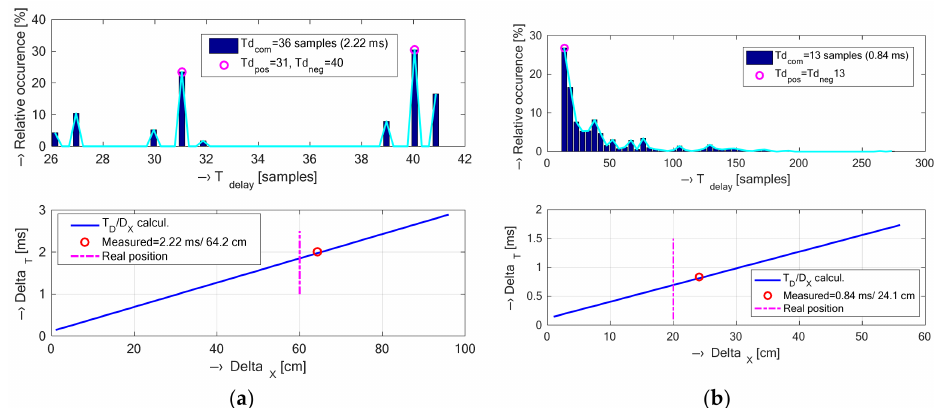
Figure 9. Histograms of evaluated time delays [samples] between electrical excitation and acoustic noise signals recorded in the MRI device (upper set), comparison of calculated and estimated mean values of time delays [ms] together with theoretical and real microphone distances (lower set); ( a ) for MRI Opera microphone Mic. 1 at a distance 60 cm and a direction 30 ◦ , sensing coil L 0 at 45 ◦ ; ( b ) for TMR96 Mic. 1 at a distance 16 cm from the patient’s bed position, L 0 at P3, sequence SE1-18 (TR = 400 ms); t = 23 ◦ C, c = 346